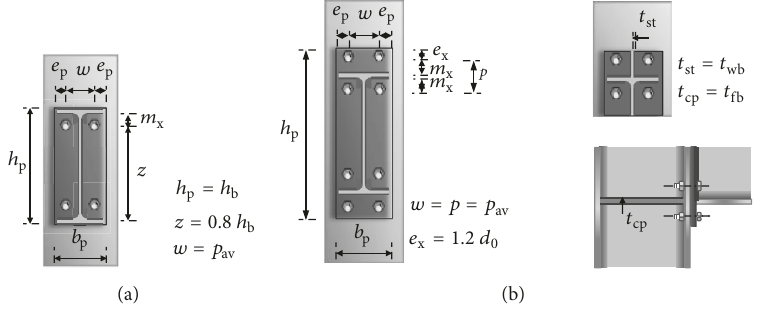
Figure 4: Basic assumptions and arrangements for flush (a) and extended (b) end-plate joints